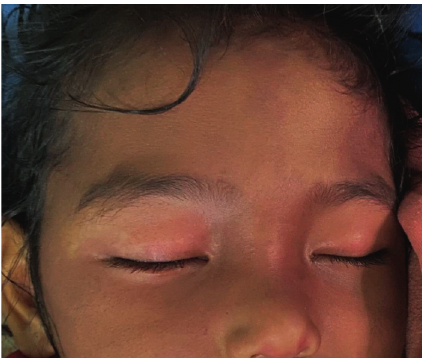
Figure 1: Port-wine stain over the right part of the forehead, periorbital area, and maxillary area (V trigeminal nerve) and left part of the forehead and periorbital area (V 1 dermatome of left trigeminal